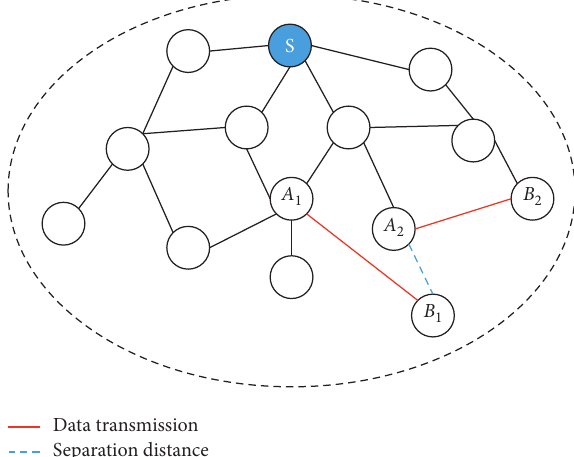
Figure 3: The schematic diagram that I I A 2 B 2